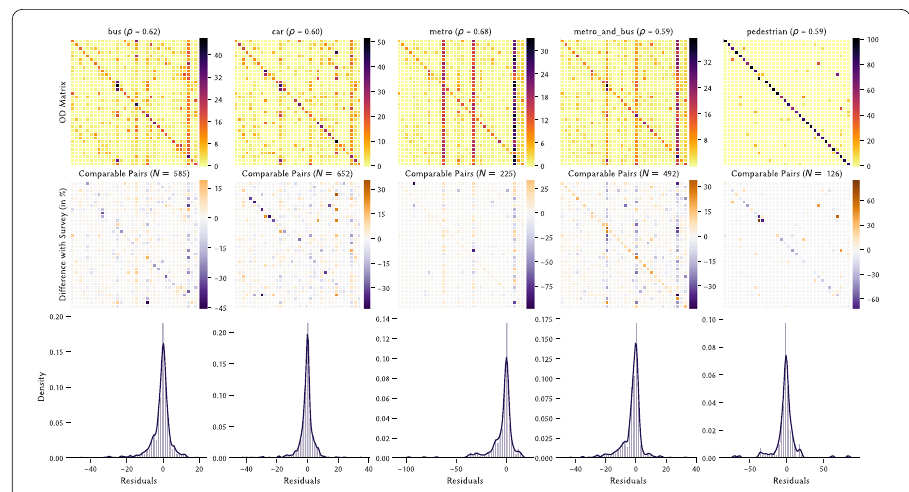
Figure 14 Top row: Origin-Destination (OD) from XDR-inferred trips for each modal cluster. Middle row: difference of XDR-inferred OD matrices with those from the Travel Survey, using a divergent color scale to understand where the matrices differ. Bottom row: distribution of the differences in the middle row, estimated with Kernel Density Estimation